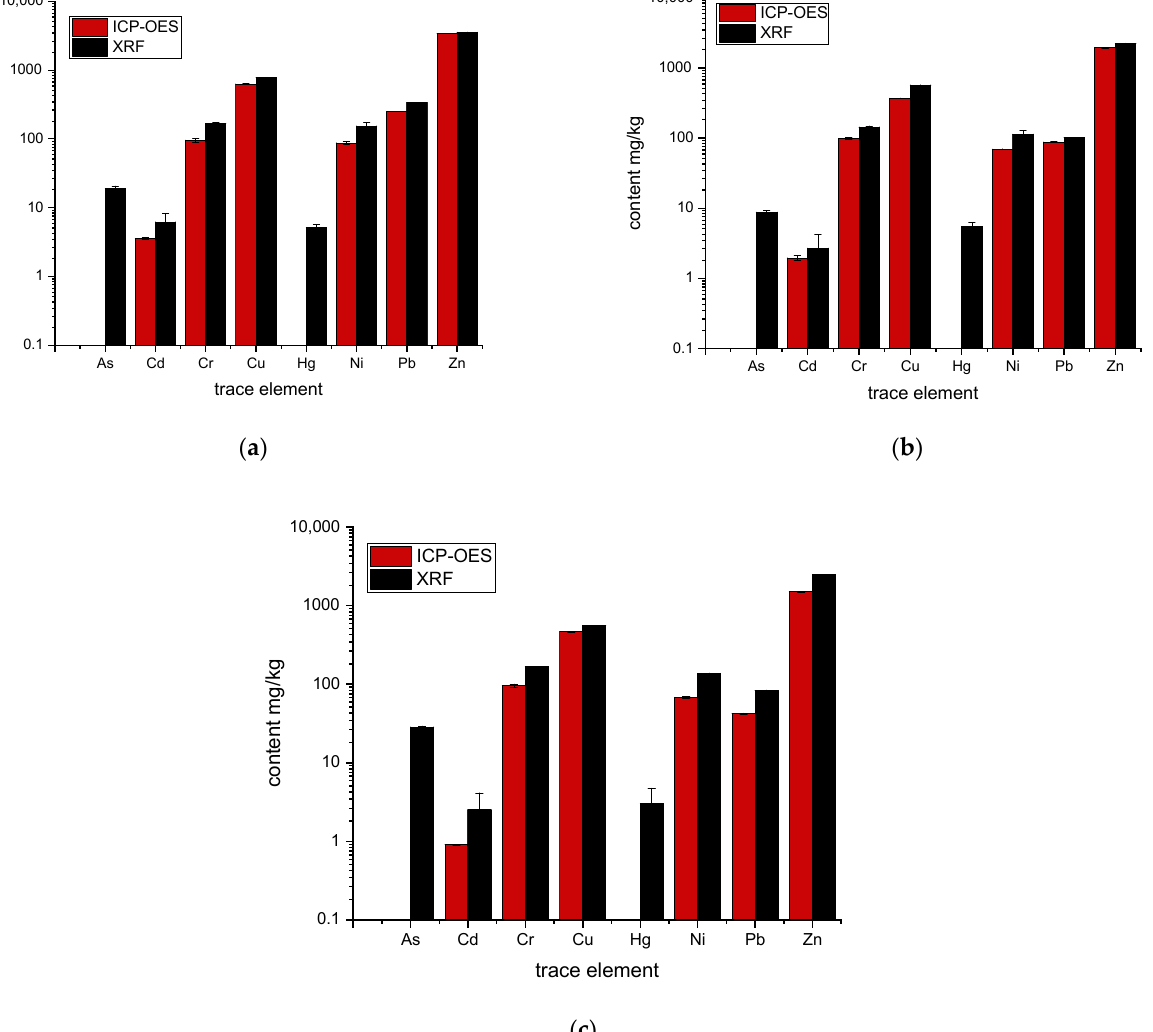
Figure 4. Trace element contents as determined by ICP-OES and XRF measurements, averages of three measurements (( a ) Leipzig data, ( b ) Dresden data, ( c ) Chemnitz